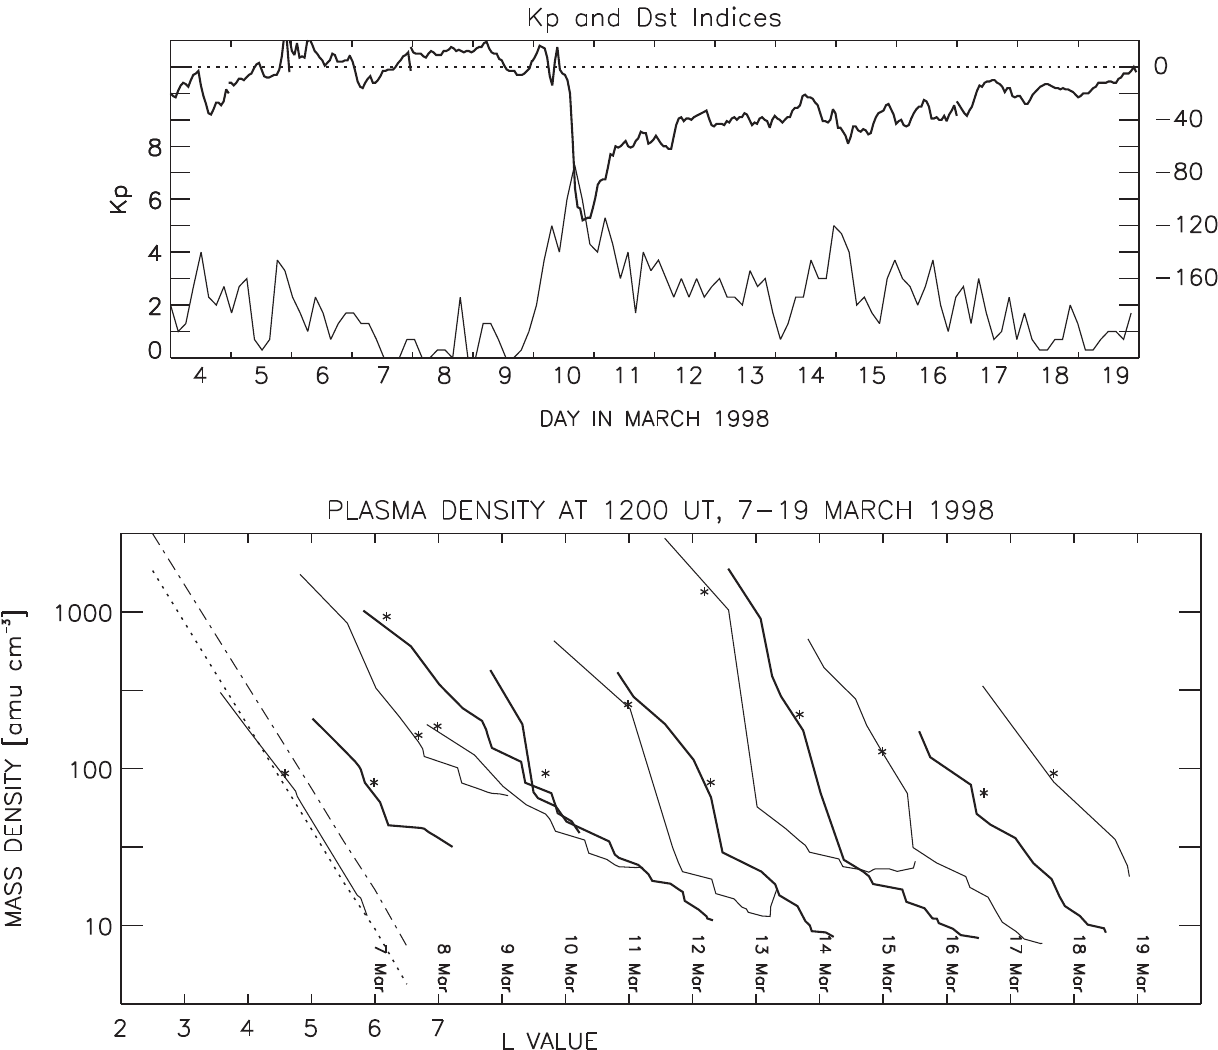
Fig. 5. Top: Kp and Dst over 4–19 March 1998. Bottom: mass density profiles at 1200 UT (LT (cid:5) UT + 1) over 7–19 March 1998. For each profile L = 6 is above the corresponding date label, and an asterisk identifies the plasmapause latitude given by the Moldwin et al. (2002) model. Heavy lines represent even-numbered days. Diagonal dotted and dashed lines at 7 March denote saturated plasmasphere electron and mass densities from the Berube et al. (2005)